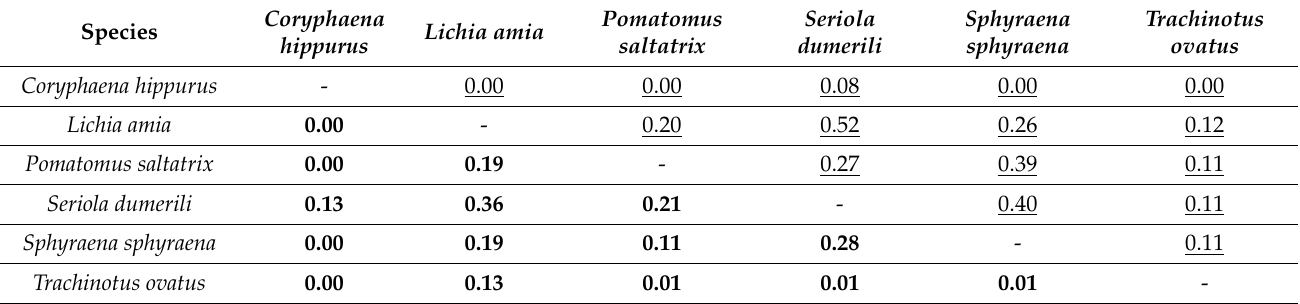
Table 2. Schoener index results based on IRI (underlined values) and mass frequency IRI (bold values) of feeding overlap of six thermophilic species caught in Bay of Medulin during 2017, 2018 and